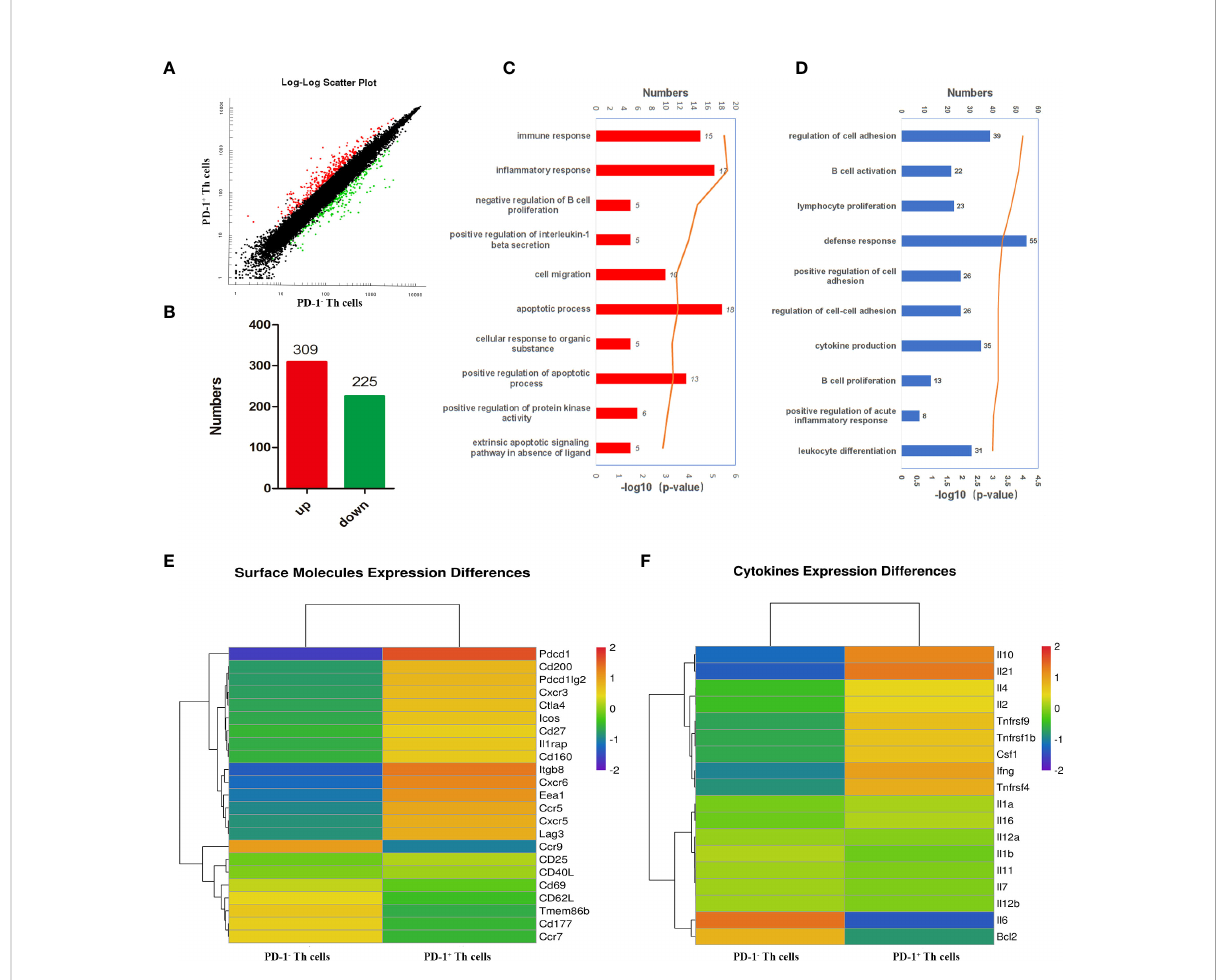
FIGURE 3 Bioinformatics analysis of the differently expressed genes between PD-1 +/- CD4 T cells post P. yoelii infection. The PD-1 + and PD-1 - CD4 T cells from the spleens of mice infected with P. yoelii were sorted and sequenced by microarray transcriptome. (A) the scatter plot showing the comparison of signal values from PD-1 + CD4 T cells and PD-1 - CD4 T cells, the dots marked in red were the up-regulated genes, the dots marked green were down-regulated genes, and the dots marked black were similarly expressed genes. (B) numbers of up-regulated and down- regulated genes in CD4 + PD-1 + T cells. (C) GO analysis showed these differentially expressed genes are mainly participated in immune response, in fl ammatory response. (D) KEGG analysis showed these genes are mainly involved in the proliferation and differentiation of lymphocytes, especially B cells. (E) The heatmap for the surface molecules expressed in PD-1 − /+ CD4 T cells. (F) The heatmap for the cytokines expressed in PD-1 − /+ CD4 T